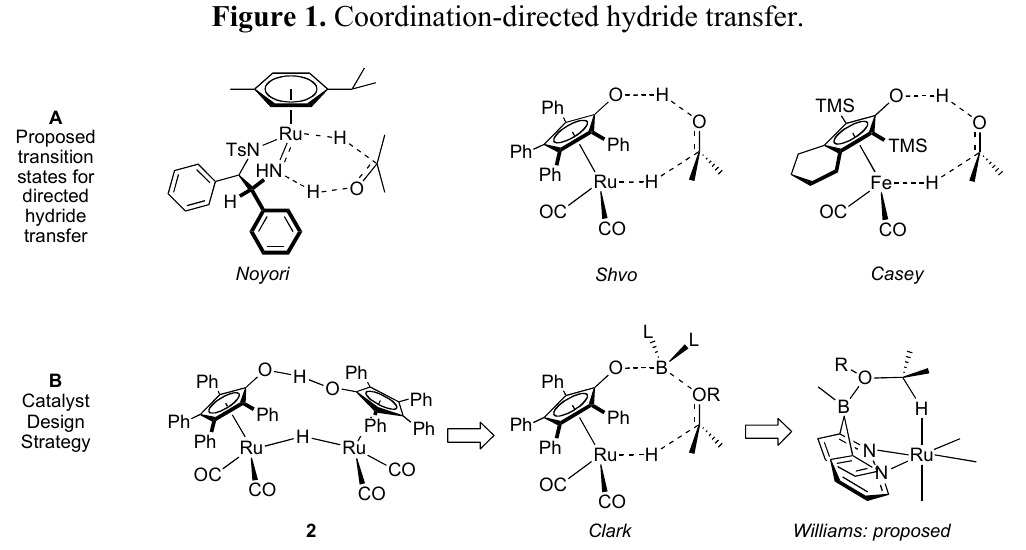
Figure 1. Coordination-directed hydride